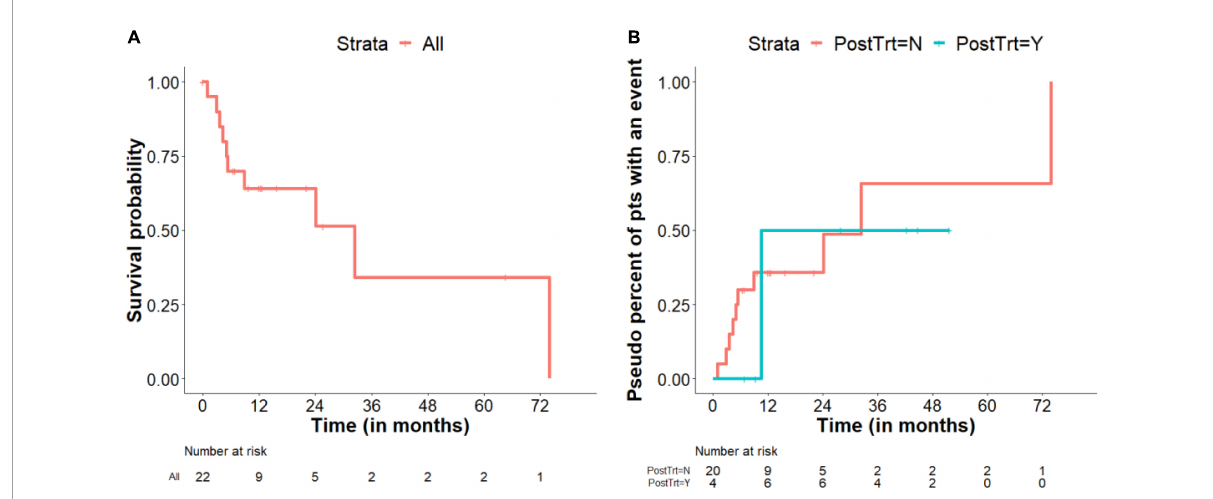
FIGURE4 Survival. (A) Kaplan–Meier survival plot includes all patients while they were under observation only. Patients who were given post-surgical advanced therapies were censored at the time of treatment initiation. (B) Pseudo percent of patients with an event (death) comparing treatment and observation alone, as a time varying covariate. The sizes of the risk sets can increase or decrease over time, depending on start time of telotristat ethyl and/or peptide receptor radionuclide therapy (PRRT); Note that the number at risk at the start of the trial is 4 for those who were treated with telotristat ethyl and/or PRRT. Two patients started telotristat ethyl and/or PRRT right after the first heart surgery. The other two patients started telotristat ethyl and/or PRRT at 6.4 and 6.9 months after the first heart surgery, which is earlier than the first death event in patients treated with telotristat ethyl and/or PRRT.